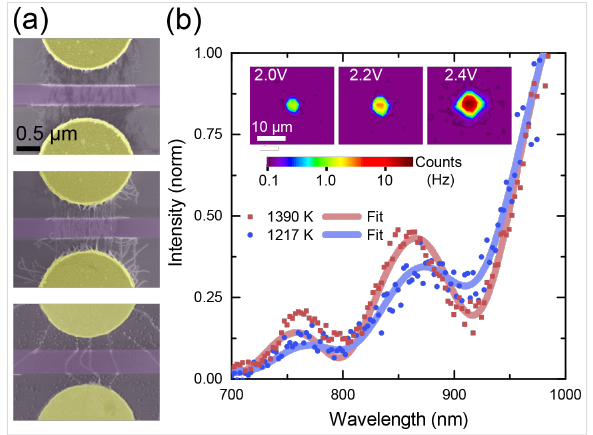
Figure 1: (a) Waveguide-integrated CNT transducers. False-colored scanning electron image of the waveguides (purple), horizontally aligned between metallic contacts (yellow). The CNTs can be seen as thin vertical lines between the electrodes crossing the waveguides. The density of CNTs varies from ca. 100 µm − 1 to ca. 10 µm − 1 to ca. 3 µm − 1 (SEM images from the top to the bottom). (b) Emission spectra from a waveguide-integrated CNT transducer, driven with 200 ns electrical pulses at 200 kHz repetition rate for 2.5 V DC + 2 V pulse (blue circles) and 2.5 V DC + 3 V pulse (red squares). The full lines are fits to a black-body radiation curve modulated by